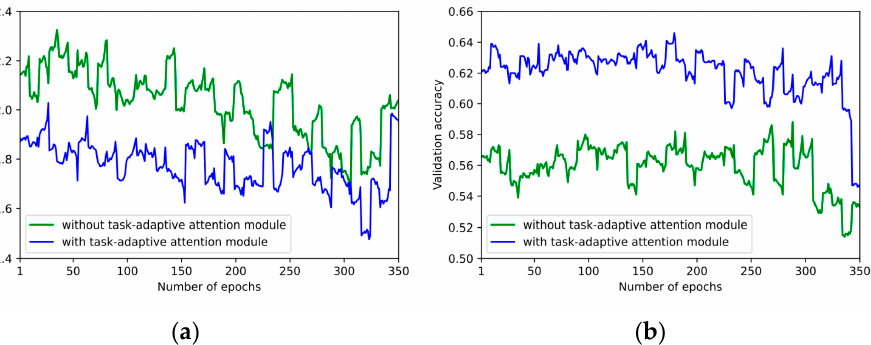
Figure 9. Validation losses and accuracies on the UC Merced dataset in the scenarios of 5-way 1-shot. ( a ) shows the validation losses, and ( b ) shows the validation accuracies.